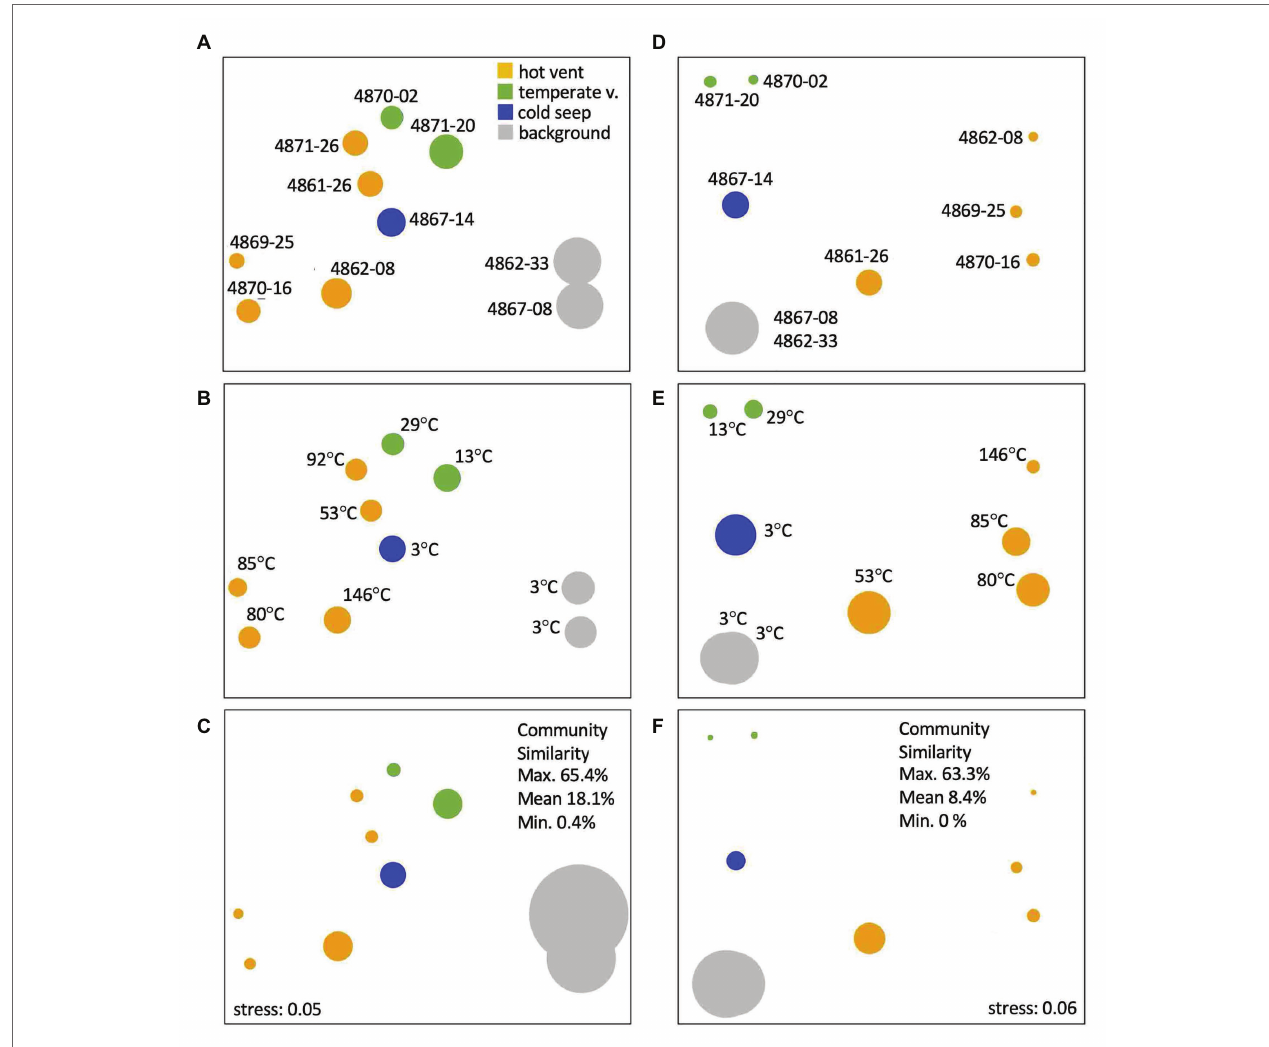
FIGURE 8 | Non-metric multidimensional scaling (NMDS) ordination plots based on 16S rRNA gene amplicons for bacterial operational taxonomic units (OTUs; A-C ) and archaeal amplicon sequence variants (ASVs; D-F ) from the upper cm of sediment cores, color-coded by geochemical cluster, and annotated with core number (A,D) and in situ temperature at 50 cm depth (B,E) . In plots (A,D) , circle size represents observed OTU richness. In plots (B,E) , circle size represents Shannon entropy. In plots (C,F) , circle size represents Inverse Simpson